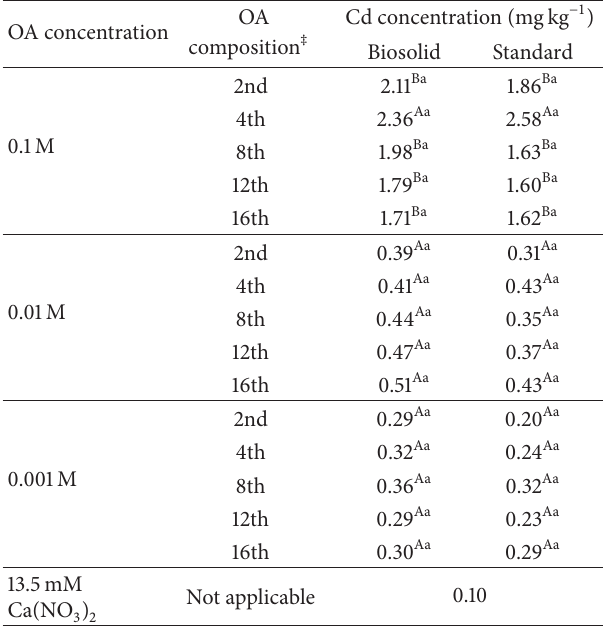
Table 2: Amounts of Cd extracted by organic acid (OA) mixtures of various compositions and concentrations †